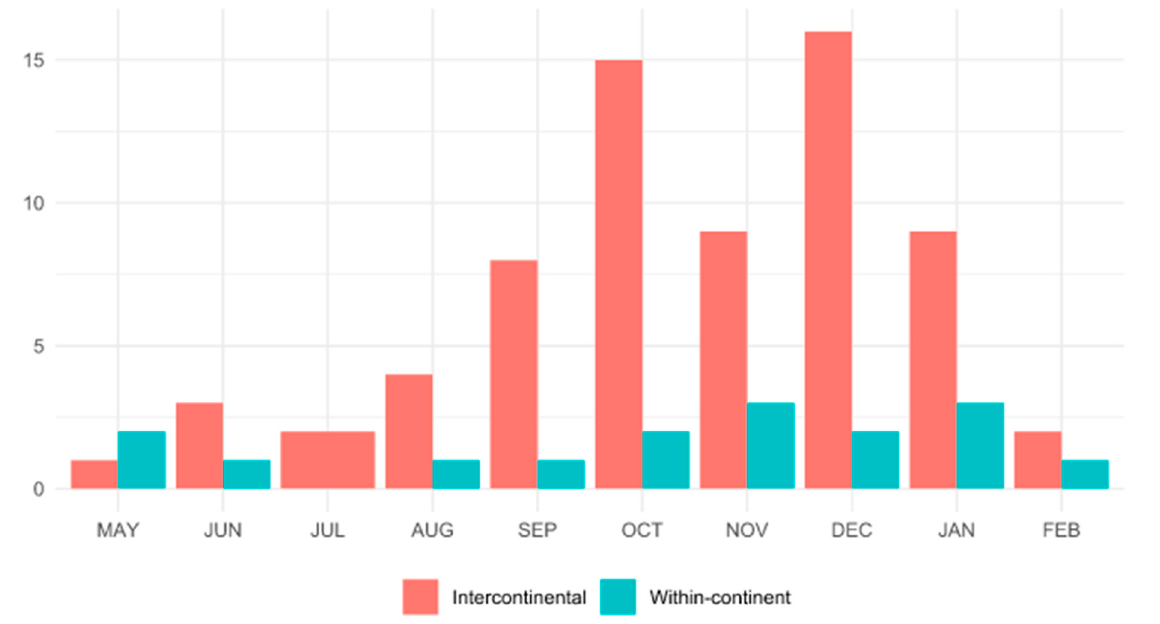
Figure A3. Temporal distribution of intercontinental (red) and within-continent (blue) dispersal of B.1.398 lineage.